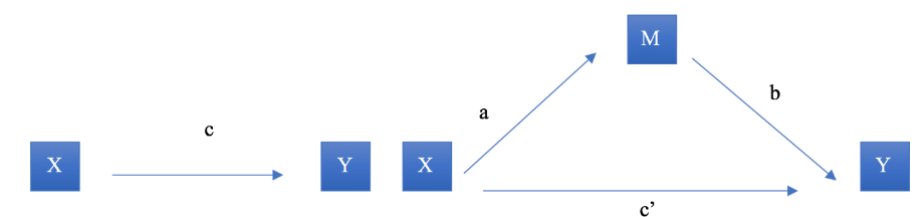
Figure 2. Mediation Diagram Based on Baron and Kenny’s (1986) Product Method.